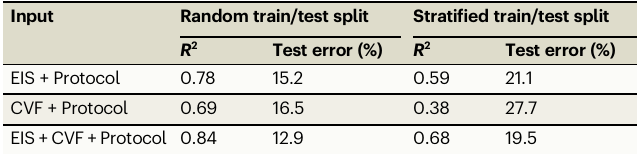
Table 1 | Comparison of state representations Table 2 | Robustness of approach to cell manufacturer